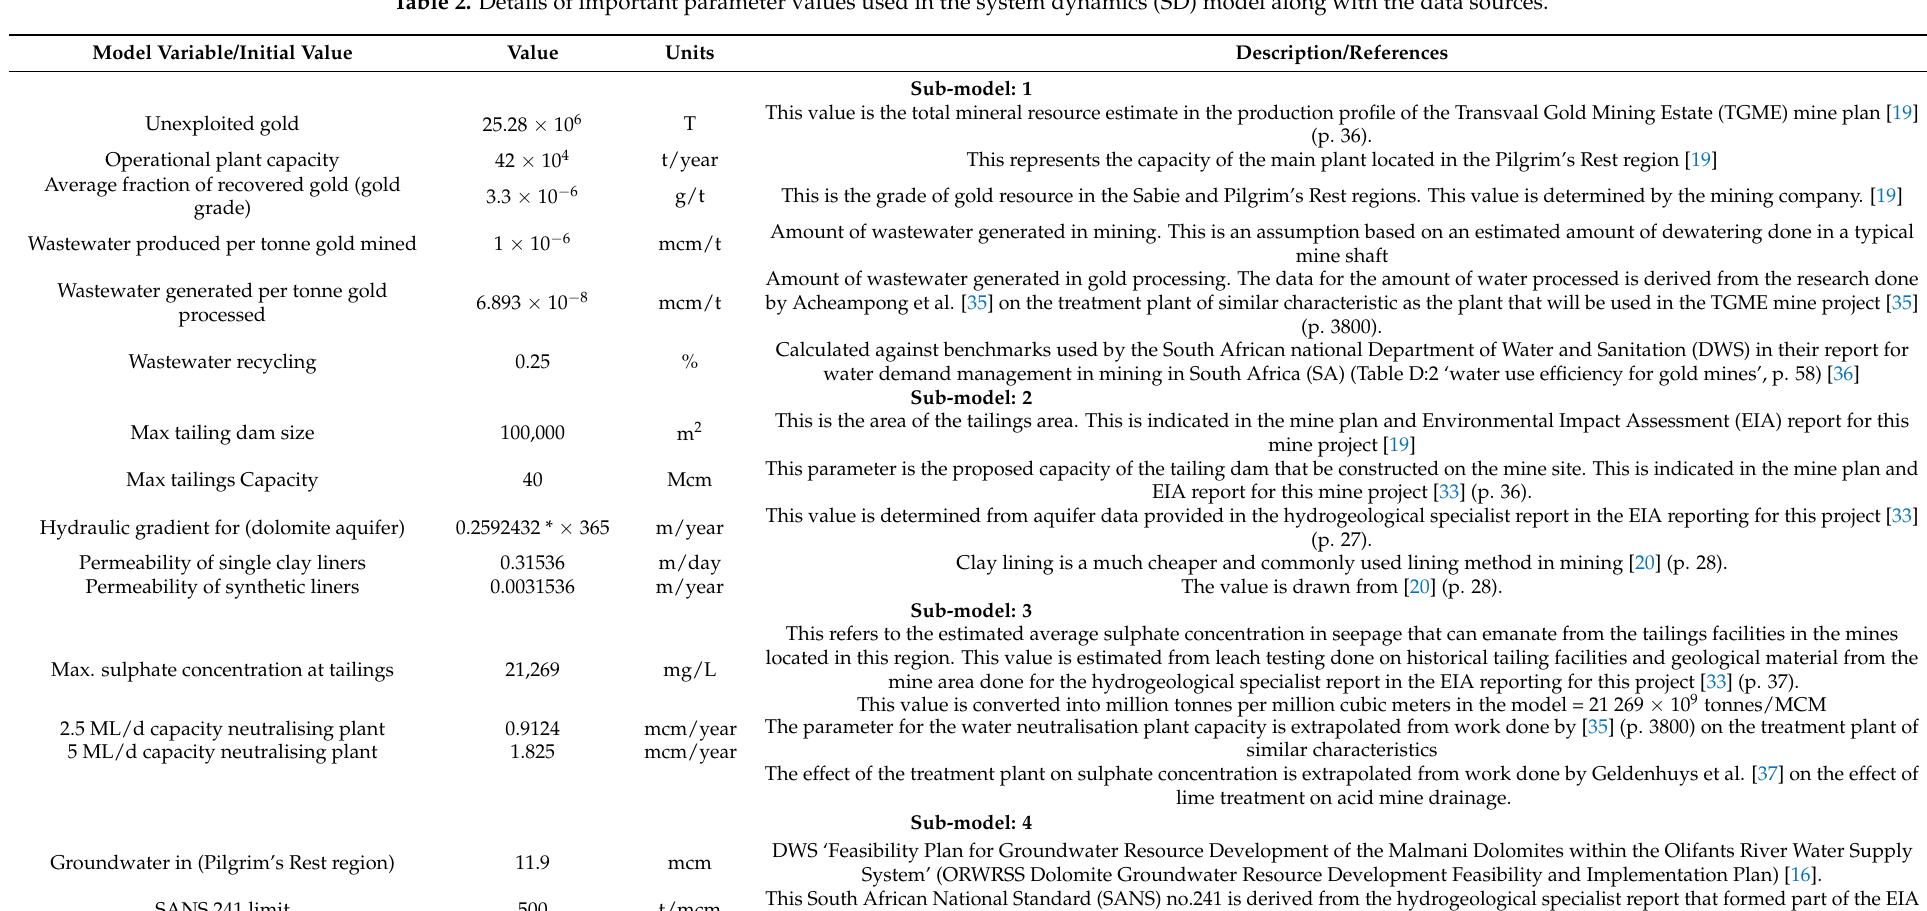
Table 2. Details of important parameter values used in the system dynamics (SD) model along with the data